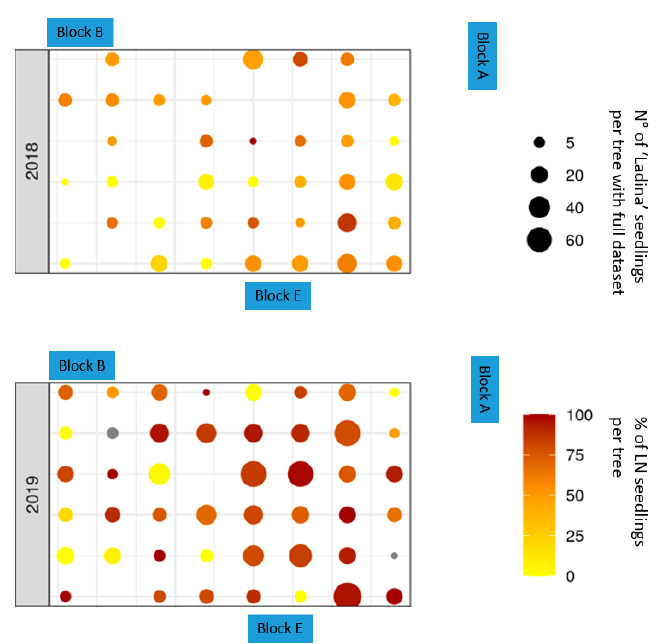
Figure 2. Spatial distribution of the ‘Ladina’ seedlings and relative amount of ‘Ladina’ seedlings originating from ‘Nicogreen’ pollinations (LN seedlings) in the netted Block 0 (grey box) for 2018 (above) and 2019 (below). The dot size indicates the number of ‘Ladina’ seedlings with full SSR dataset per tree and the color the relative proportion of seedlings originating from ‘Nicogreen’ pollinations (LN seedlings). Only Nicogreen blocks (blue boxes) in proximity to the netted Block 0 are indicated.